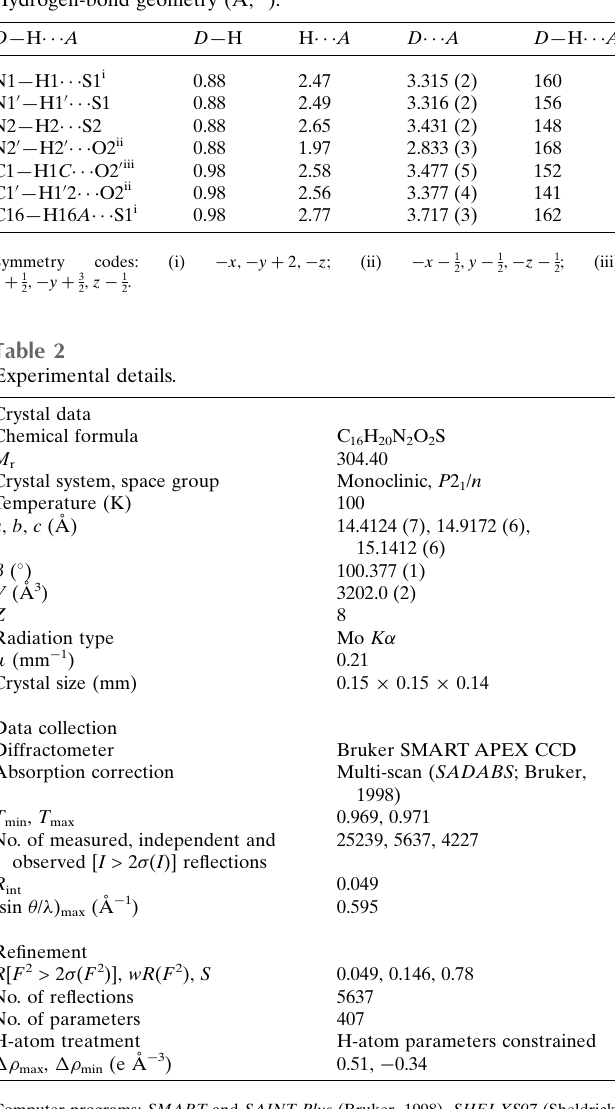
Table 1 Hydrogen-bond geometry (A˚ , (cid:3) ).